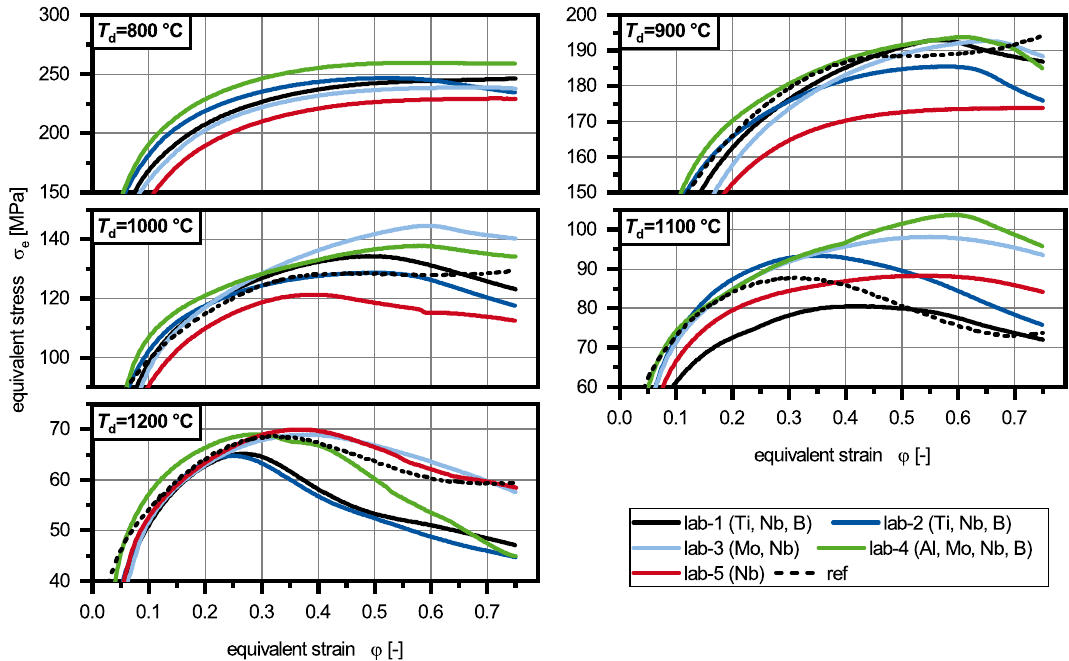
Figure 6. Influence of the chemical composition on the flow curves of alloys lab-1 to lab-5, determined at deformation temperatures from 800 ◦ C to 1200 ◦